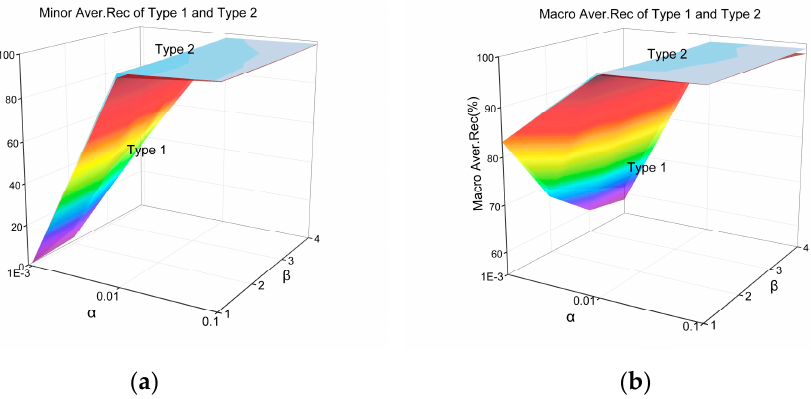
Figure 8. Classification performance comparison of Type 1 and Type 2 on Moore dataset. ( a ) Minor Aver.Rec; ( b ) Macro Aver.Rec.